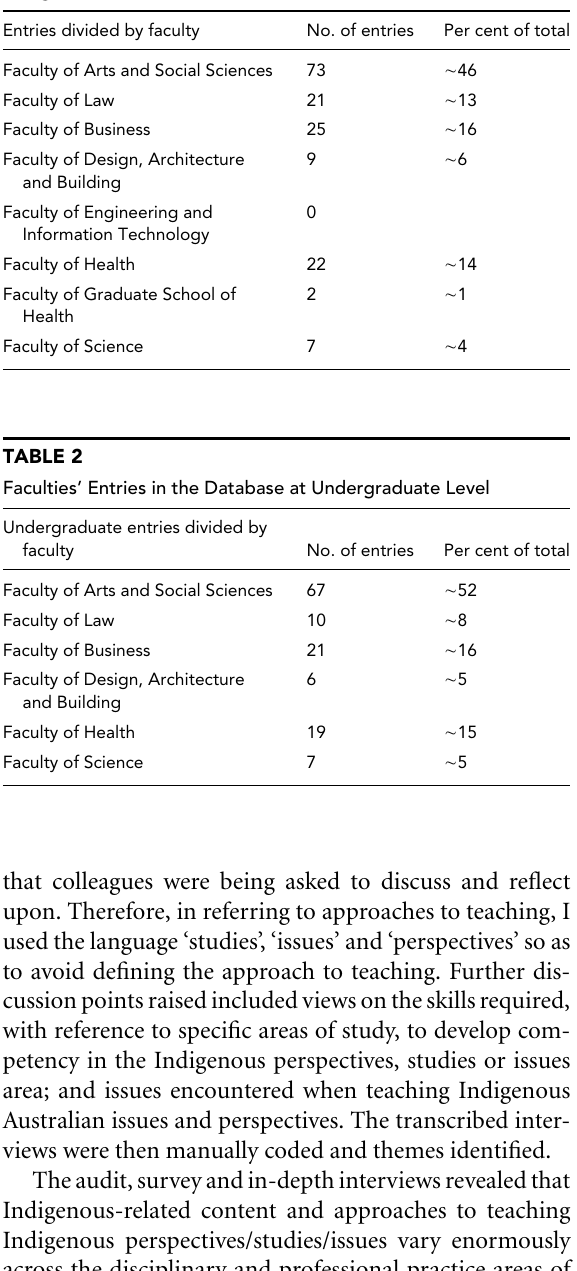
Activities Reflecting Indigenous-Related Content, Perspectives or